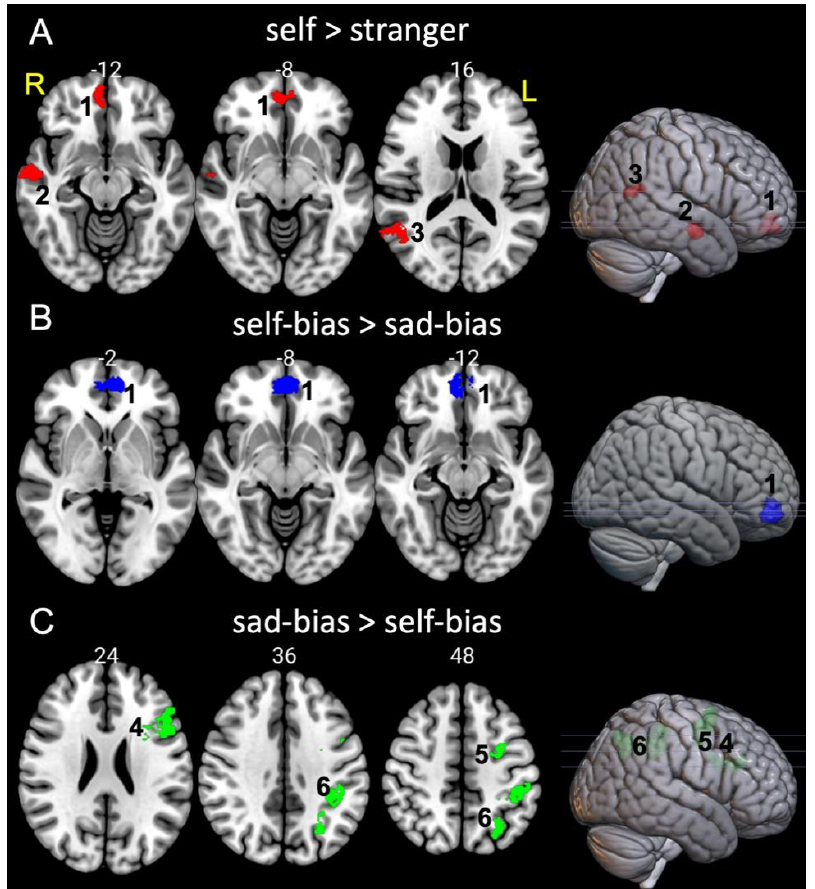
Figure 3. Activation results for the whole-brain univariate analyses for contrasts [self > stranger] ( A ), [self-bias > sad-bias] ( B ), and [sad-bias > self-bias] ( C ). The mask of clusters with significant univariate effects (a cluster corrected FDR-threshold of p < 0.05, voxel-threshold p < 0.001 uncorrected, extended threshold of 30 contiguous voxels) was created and overlaid on an MNI152 standard template using MRIcroGL (radiological convention).1—vmPFC (ventromedial prefrontal cortex), 2—R-STG (right superior temporal gyrus), 3—R-AG (right angular gyrus), 4—L-IFG-Tri (left inferior frontal